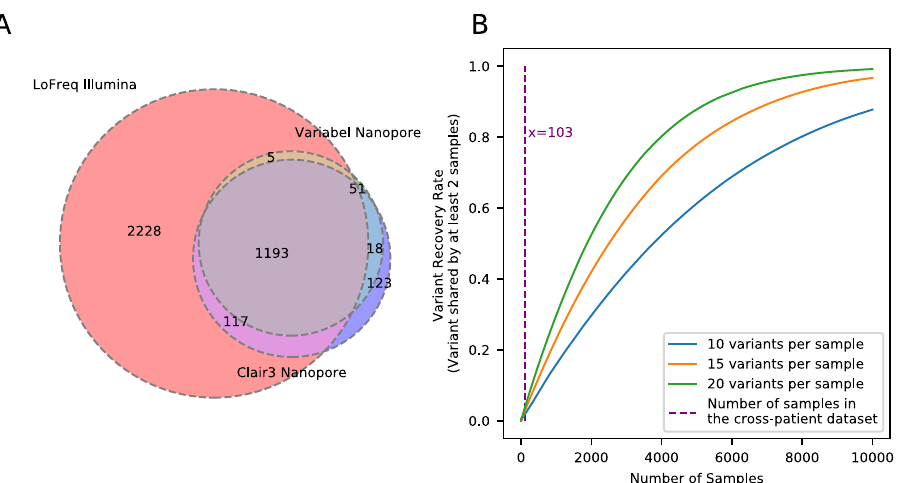
Fig. 4 Intra-host variant detection on the COVID-19 cross-patient dataset. A Venn diagram showing counts of variant calls shared between LoFreq on Illumina sequencing runs and Variabel and Clair3 on nanopore sequencing runs on the same samples from the cross-patient dataset. B Simulation of fraction of shared variants recovered from different sizes of collections of COVID-19 samples. For both A and B , source data are provided as a Source Data fi le.